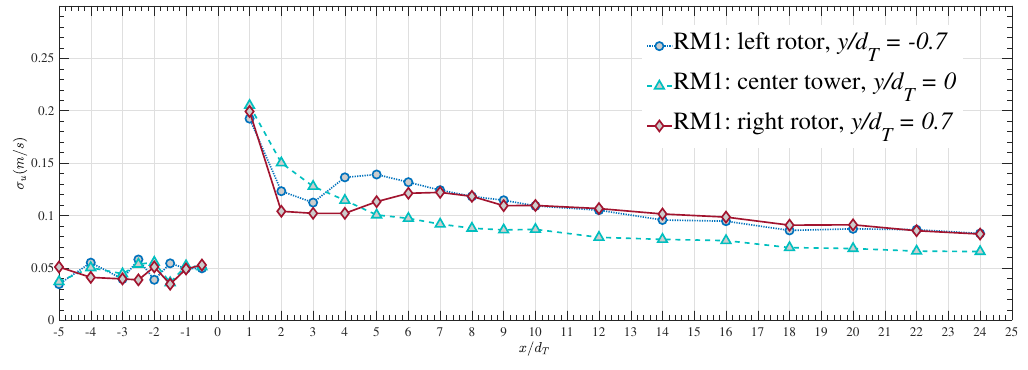
(cid:112) u (cid:48) 2 ). RM1 rotors located at x / d T = 0.